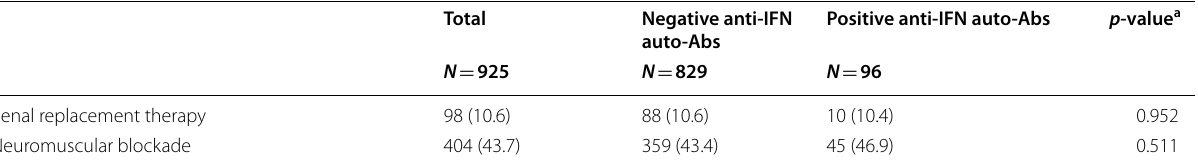
Table 2 Intensive care management and outcomes of patients with severe SARS‑CoV‑2 infection ( n admission, according to the presence of auto‑antibodies against type I IFNs